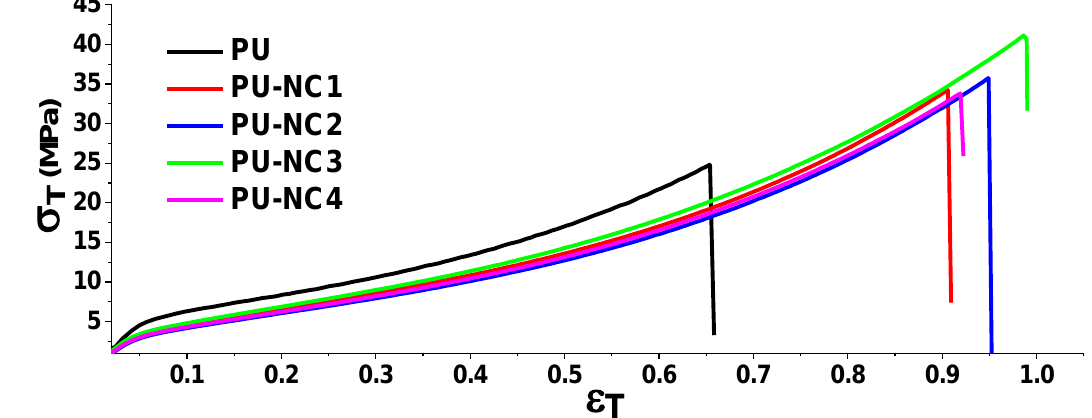
Polymers 2021 , 13 , x FOR PEER REVIEW